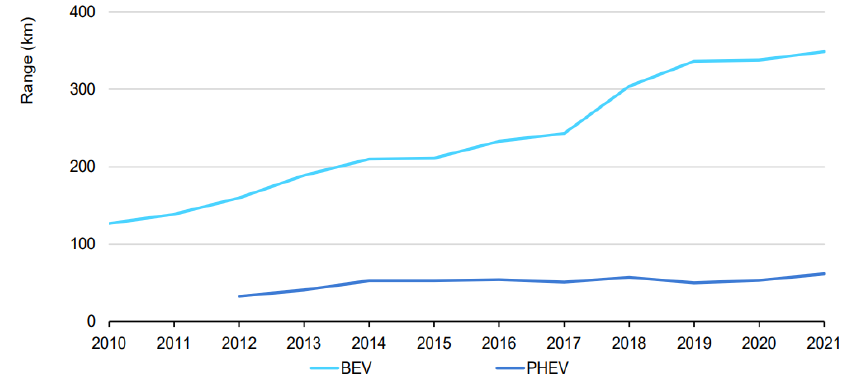
Figure 7. Evolution of average driving range electric vehicle by powertrain 2010 – 2021 [62].